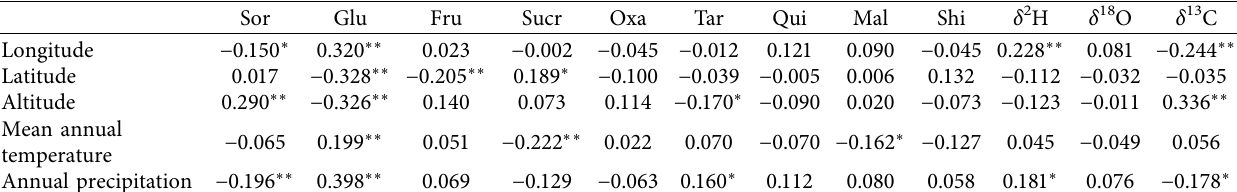
Table 4: Correlations of soluble sugars, organic acids, and stable isotopes with regional conditions.